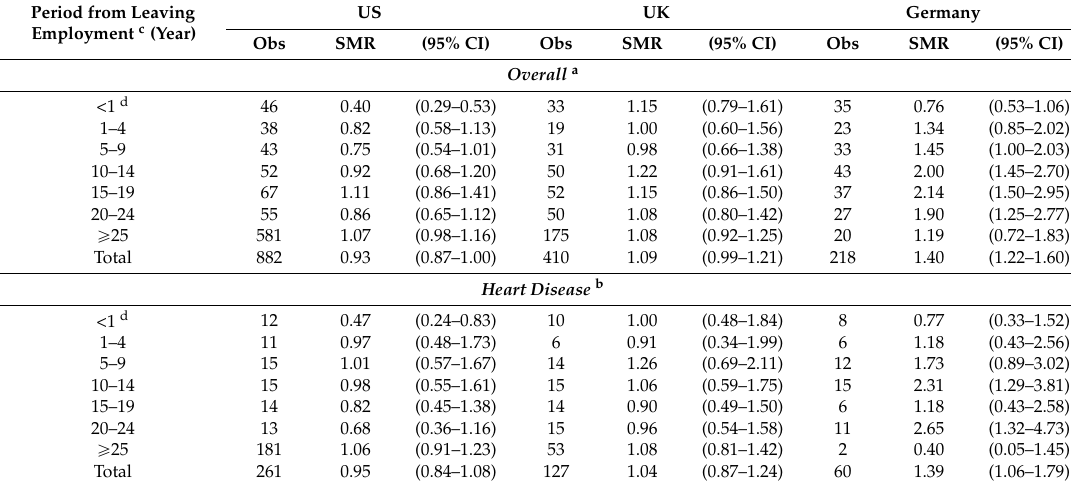
Table 5. Standardised mortality ratios (SMRs) for overall a and cardiac b mortality based on national rates by period from leaving employment, in carbon black production workers (inception cohorts, US: follow-up ě 1979).